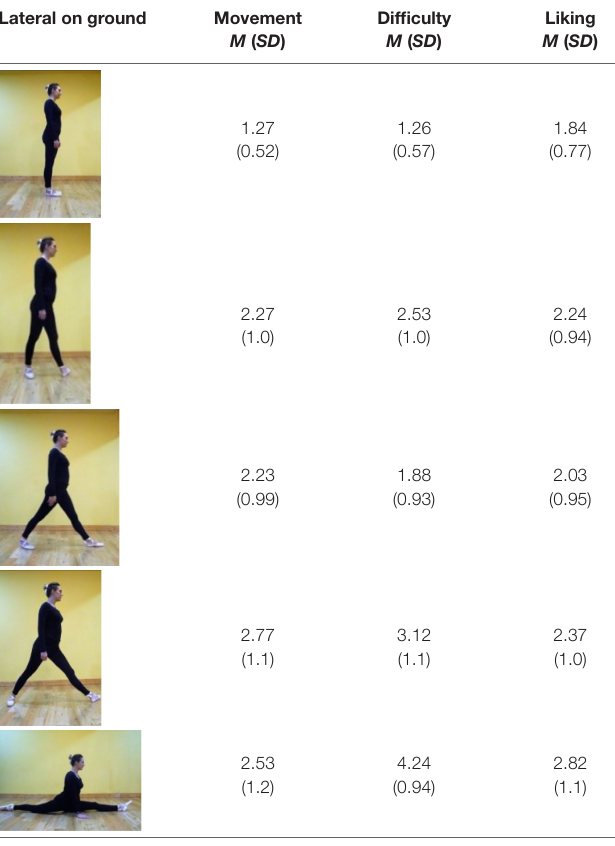
TABLE 4 | Lateral on-ground poses: mean ratings (and SD) for movement, difficulty, and liking. Lateral on